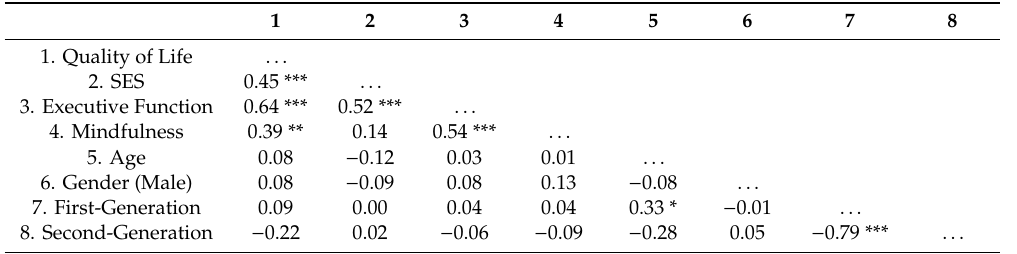
Table 2. Pearson’s correlation coe ffi cients of